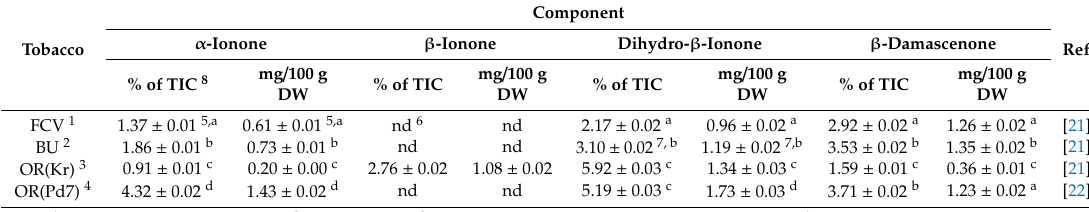
Table 2. Content of carotenoid derivatives in tobacco